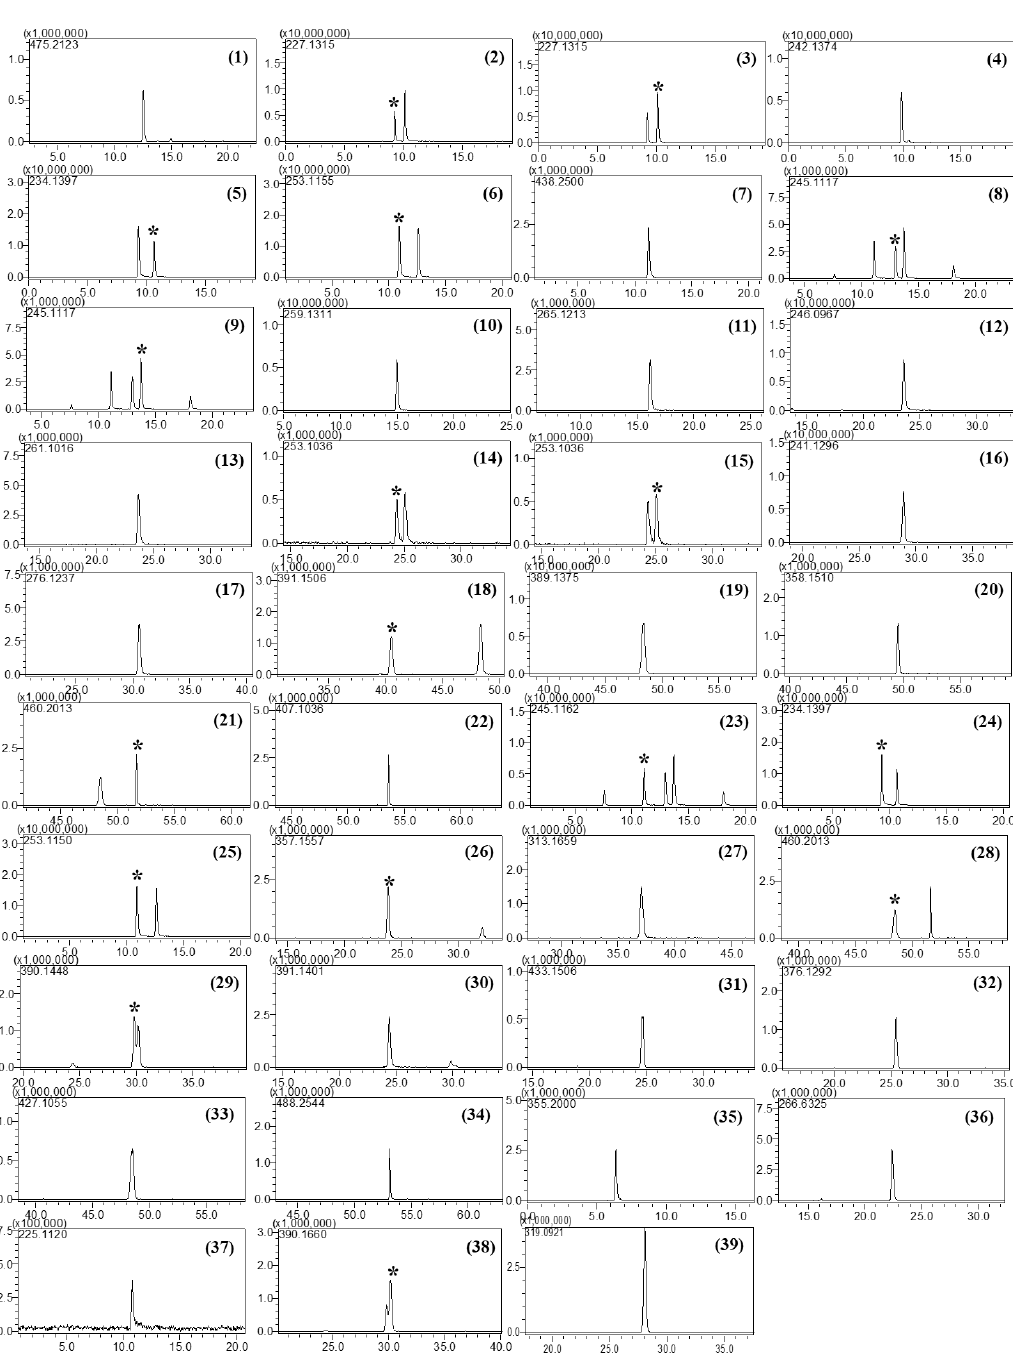
Figure 1. Extracted ion chromatograms of PDE-5 inhibitors and their analogs: Sildenafil ( 1 ), carbodenafil